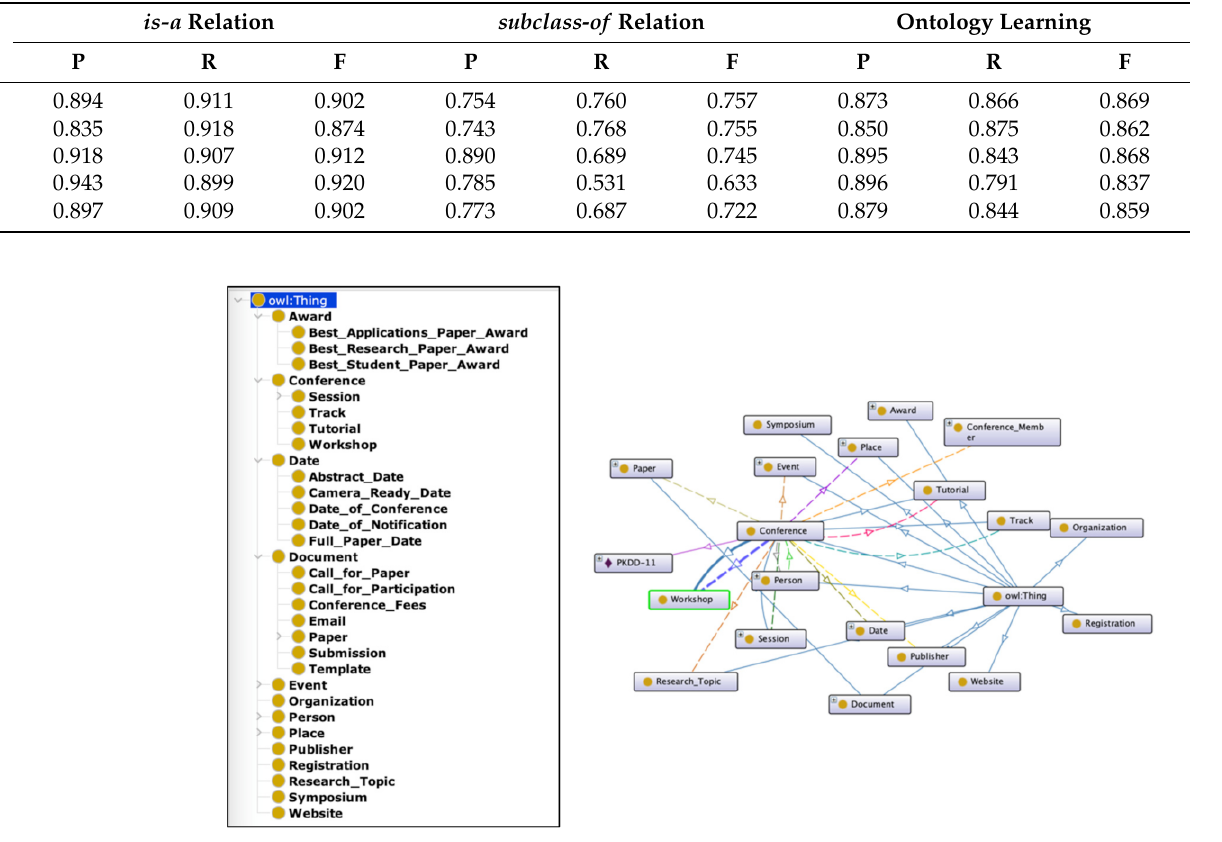
Table 5. Performance of ontology learning.